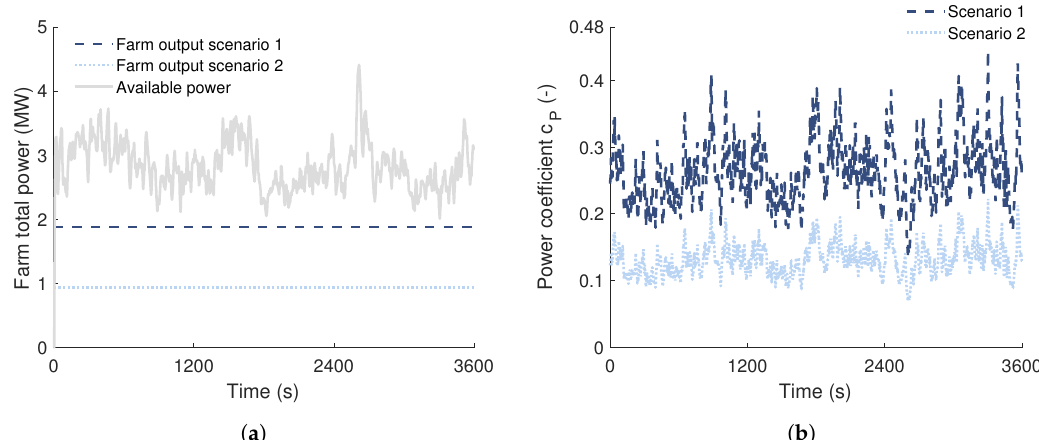
Figure 6. Wind farm in two operation scenarios used for demonstration of effect of update limit on model update frequency, model accuracy and computational cost. Shown are ( a ) total power of wind farm and ( b ) power coefficient at upstream turbine.